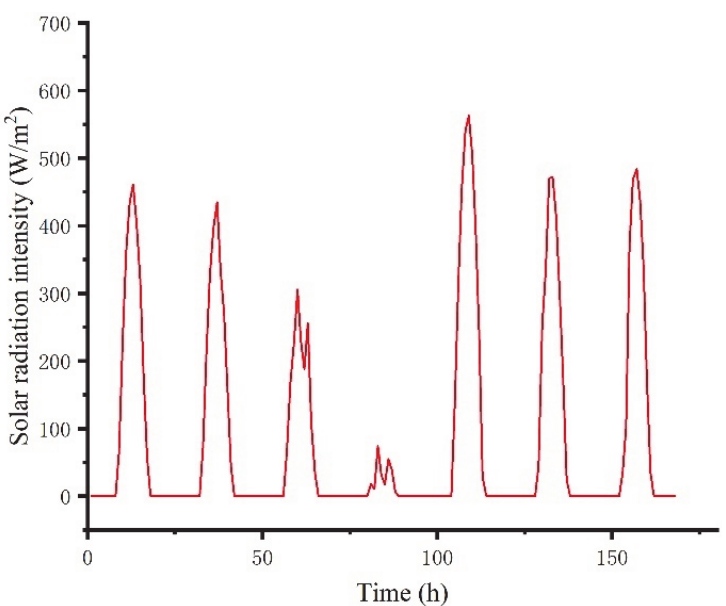
Figure 10. Hourly solar radiation intensity. Table 4. Parameters settings for the Actor